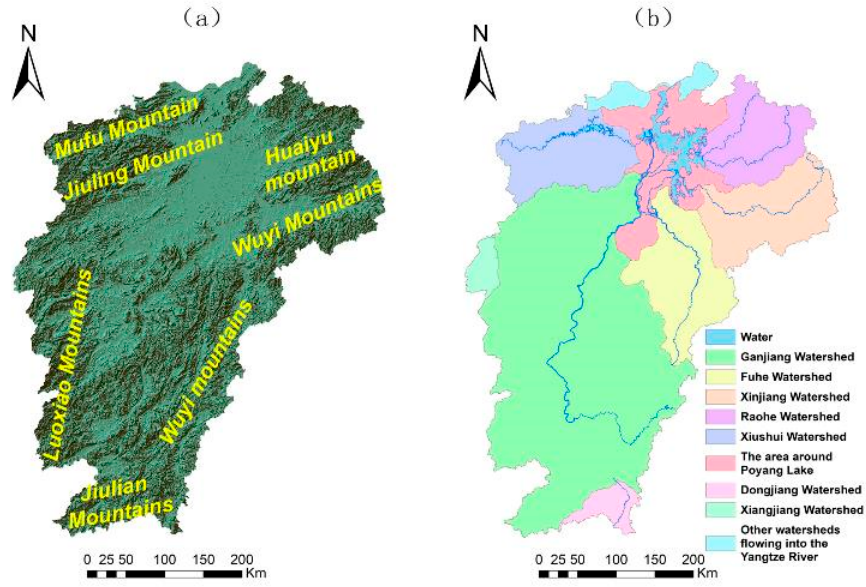
Figure 1. Geographical pattern of the study region: ( a ) major mountains; ( b ) major rivers and wa- tersheds.